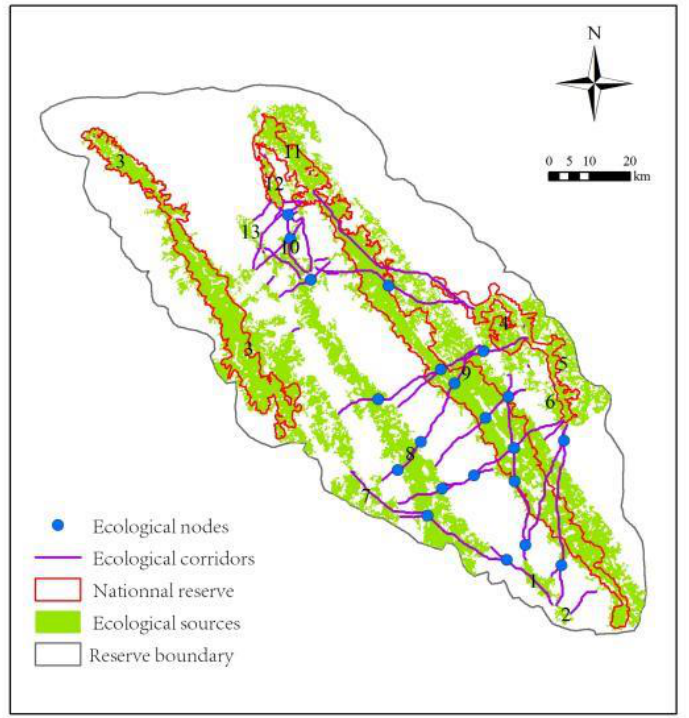
Figure 4. Ecological network of the national park.